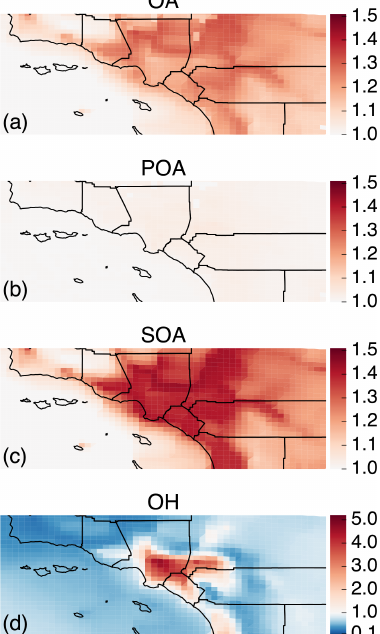
Figure 10. Ratios of 14-day-averaged model predictions of (a) OA, (b) POA, (c) SOA, and (d) OH from 2035 to those from 2005. The 2035 simulations were performed with 2005 meteorological inputs but scaling the anthropogenic emissions for CO, NO x , VOC, PM 2 . 5 , SO 2 , and NH 3 based on changes projected by the California Emis- sion Projections and Analysis Model (CARB,